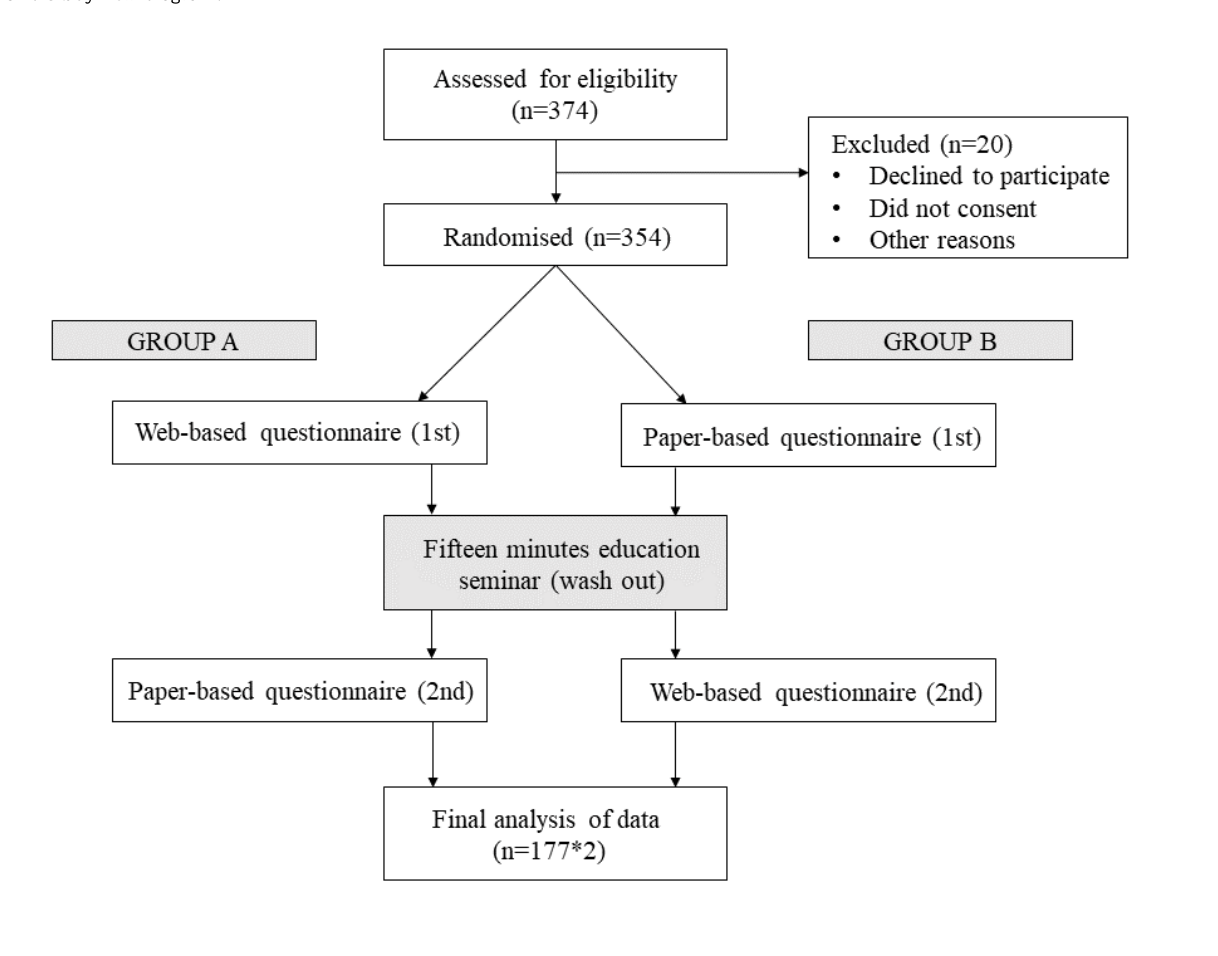
Figure 1. Study flow diagram.